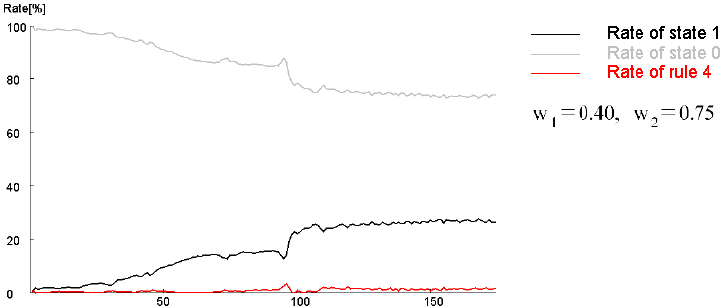
Figure 15. Transition of the ratios of states 1 and 2, and the ratio of the applied cells of Rule 4 per time step under the same conditions as in Figure 12 ( s = 5, t = 9, w 1 = 0.40, and w 2 = 0.75). From 90 to 100 steps, the frequency of pattern division became high, and the application ratio of Rule 4 increased.